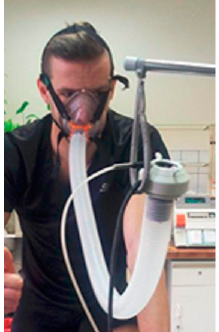
Figure 2. One of the participants with the added respiratory dead space volume (ARDS V ) device.